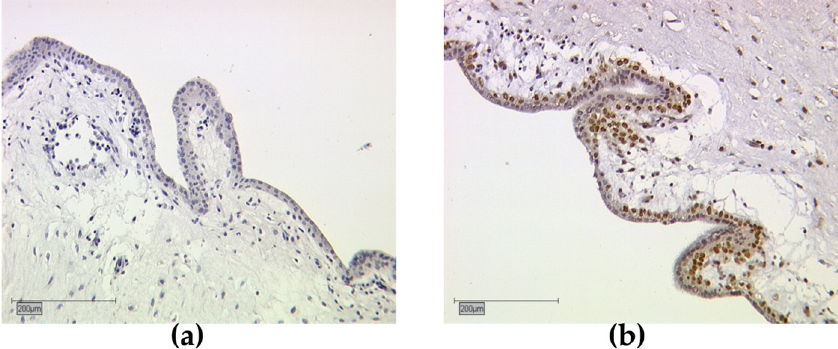
Figure 1. Immunohistochemical staining of retinoid X receptor (RXR) in human placenta tissue, serving as negative and positive control; ( a ) RXRα-negative control and ( b ) positive control. ( a , b ) shows 10× (scale bar = 200 μm) magnification. 10 × (scale bar = 200 µ m)